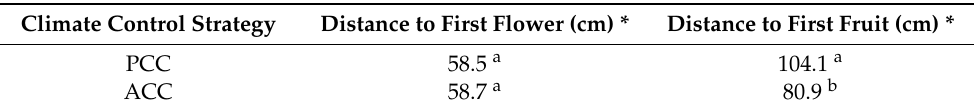
Table 1. Distance from the ground to the first flower and to the first fruit in “Siluet” papaya grown in PCC and ACC modules.